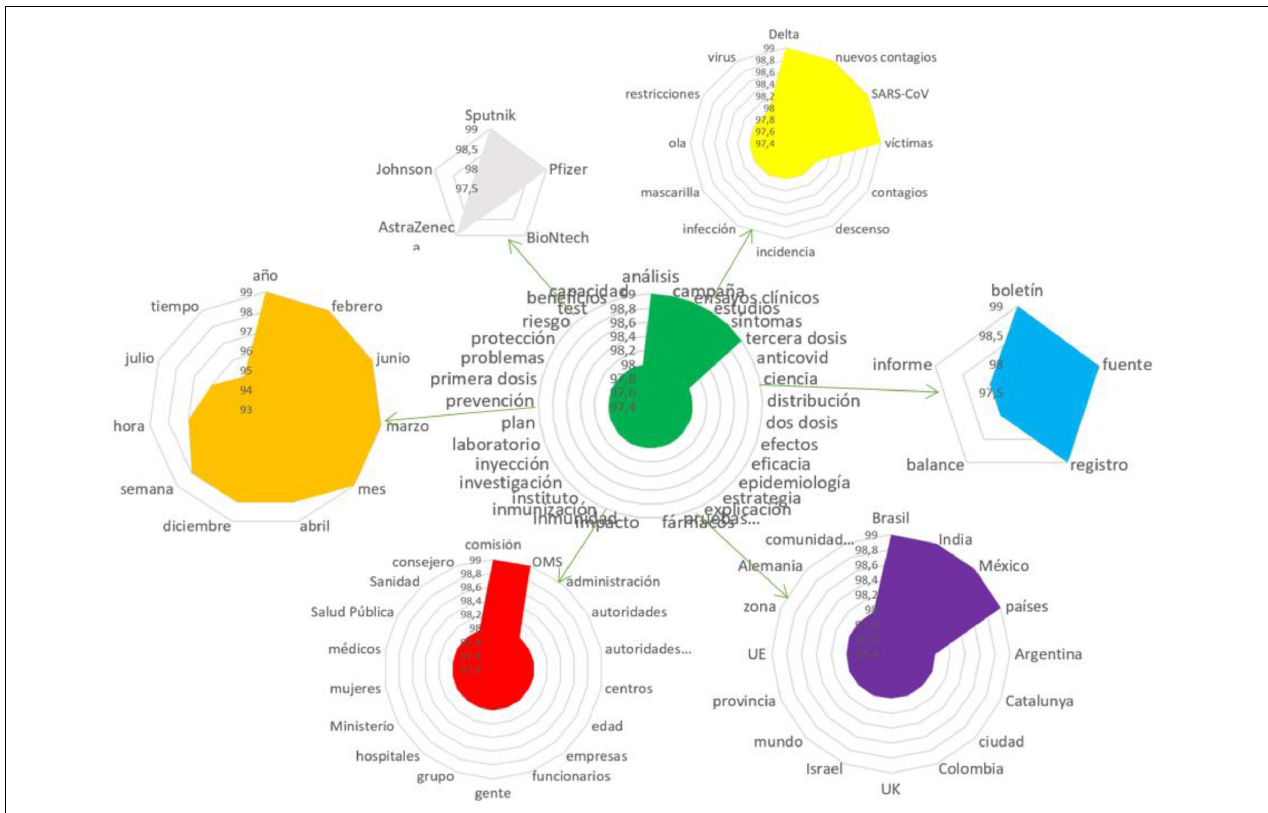
FIGURE 1 | Features of vaccine production and specificity of